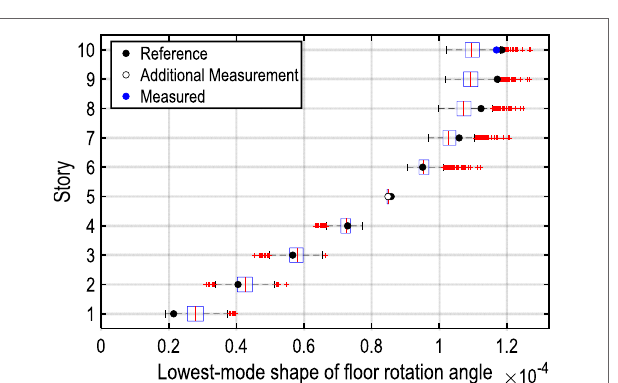
FIGURE 10 | Relationship between cumulative distribution function and boxplot.